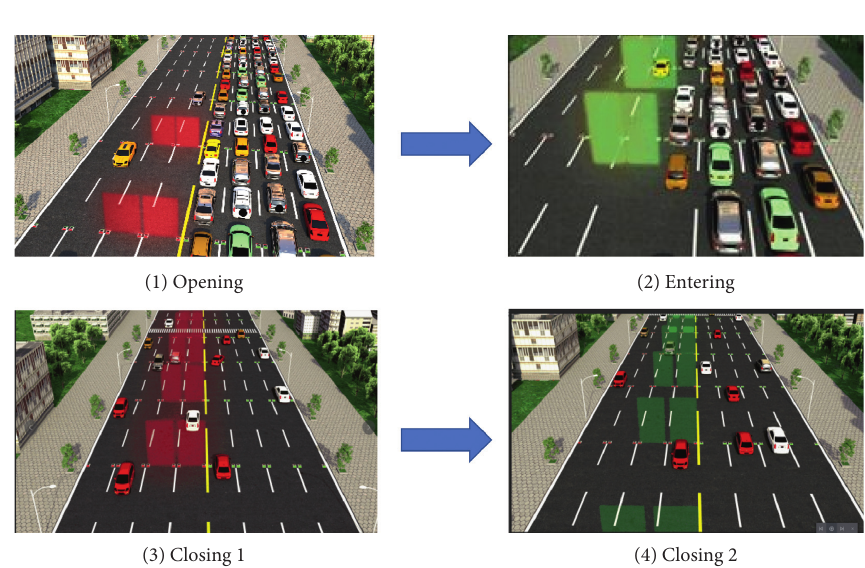
Figure 6: Illustrations of the real-time dynamic reversible lane operation